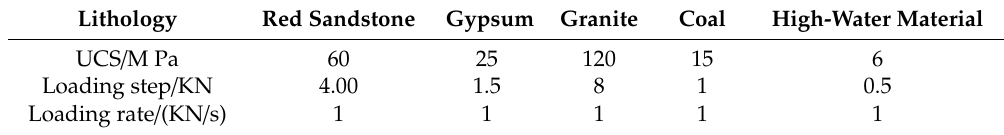
Figure 4. Typical stress–strain curve with the nth load–unload cycle. Table 2. Strength and loading parameters for different rocks. UCS: uniaxial compressive strength. Lithology Red Sandstone Gypsum Granite Coal High-Water Material UCS / M Pa 60 25 Loading step /